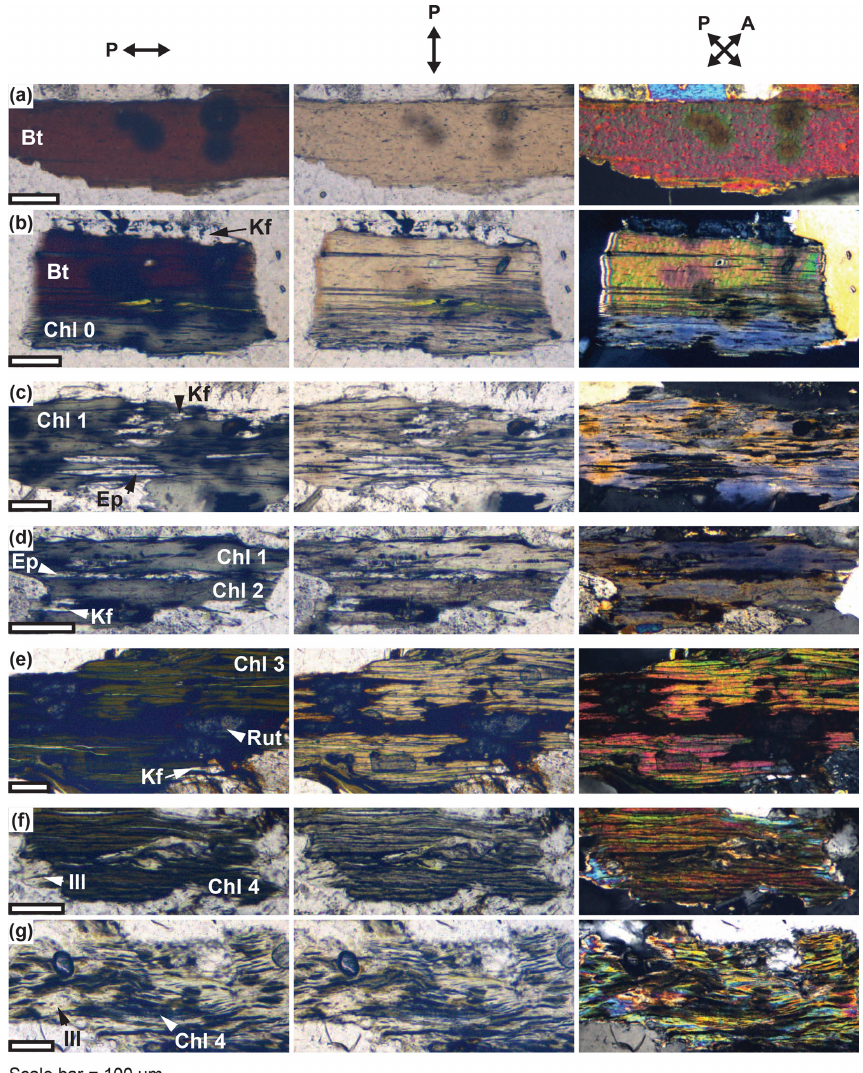
Figure 5. Polarized light photomicrographs showing optical properties of biotite and its alteration products. The double-headed arrows show polarization direction of polarizer (P) and analyzer (A) for each column; (a) biotite and (b) biotite partially replaced by chlorite (Chl 0) in fresh granite; (c) chlorite (Chl 1) in weakly altered granite; (d) chlorite (Chl 1 and Chl 2) in green granite; (e) chlorite (Chl 3) in brown granite; (f, g) chlorite (Chl 4) and illite in yellow granite. Bt: biotite, Kf: K-feldspar, Ep: epidote, Rut: rutile and Ill: